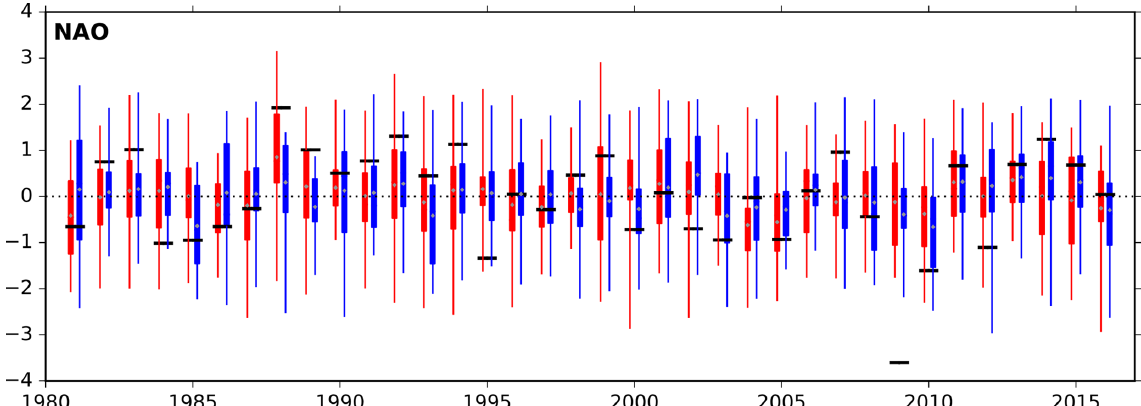
Figure 11. Time series of a DJF NAO index derived from projecting the re-forecast 500hPa geopotential height onto the first EOF of ERA- Interim DJF 500hPa geopotential height in the North Atlantic. Quartiles, minimum and maximum of the SEAS4 25-member ensemble are shown in blue, while the SEAS5 25-member ensemble is shown in red and ERA-Interim reanalysis is shown in the black bars. Forecasts were initialised in November, and the year shown is the year the ensemble was initialised. The grey diamonds indicate the ensemble mean. Anomaly correlation values for the ensemble mean are 0.46 for SEAS4 and 0.43 for SEAS5. The 95% confidence interval for sampling error over years is 0.12 to 0.67 for SEAS5.